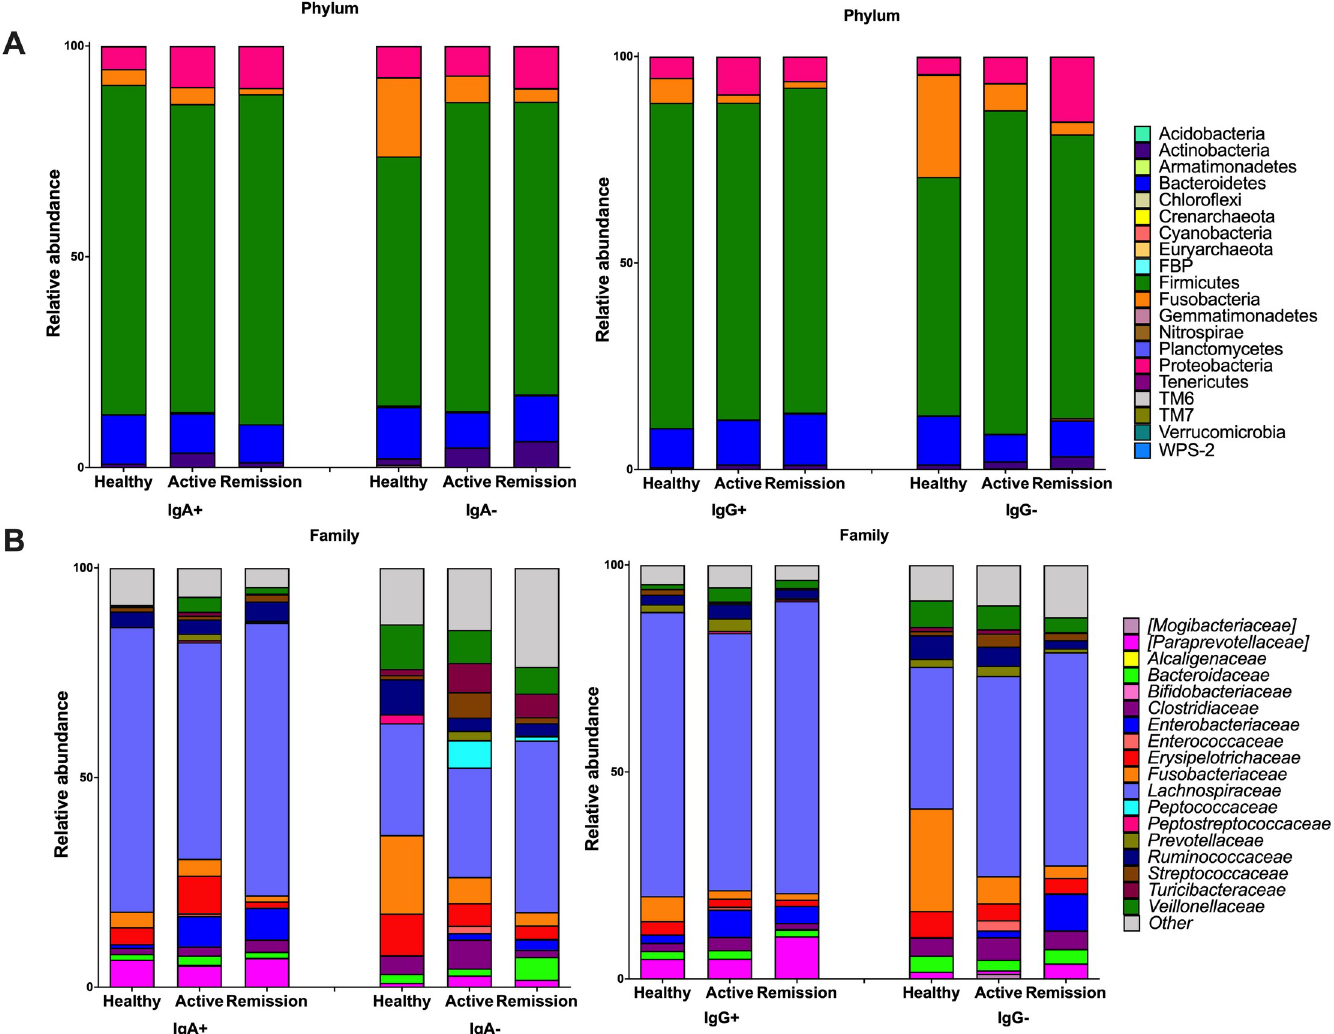
Fig 3. Average relative abundance of IgA and IgG positive and negative populations at phylum (A) and family (B) level in healthy dogs and dogs with chronic enteropathy during active disease and remission.